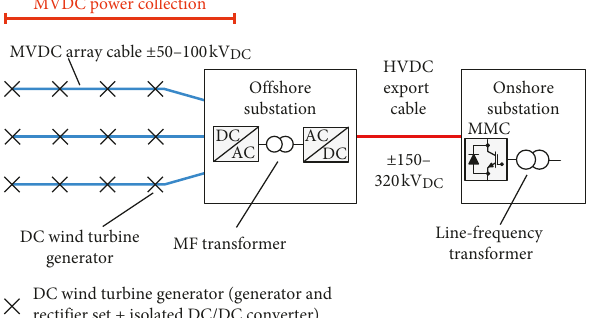
Figure 1: General configuration of the wind power plant with MVDC power collection.